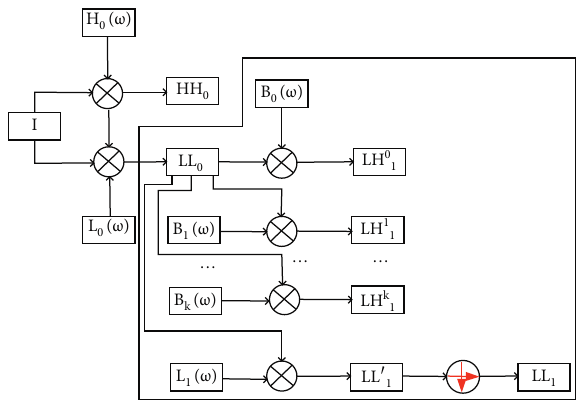
Figure 6: Flowchart of